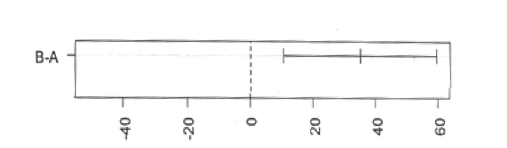
Figure 6 - 95% family-wise confidence level for final body weight, indicates a significant difference between A and B due to non- intersection of the horizontal line (B-A) with the broken vertical line at 0